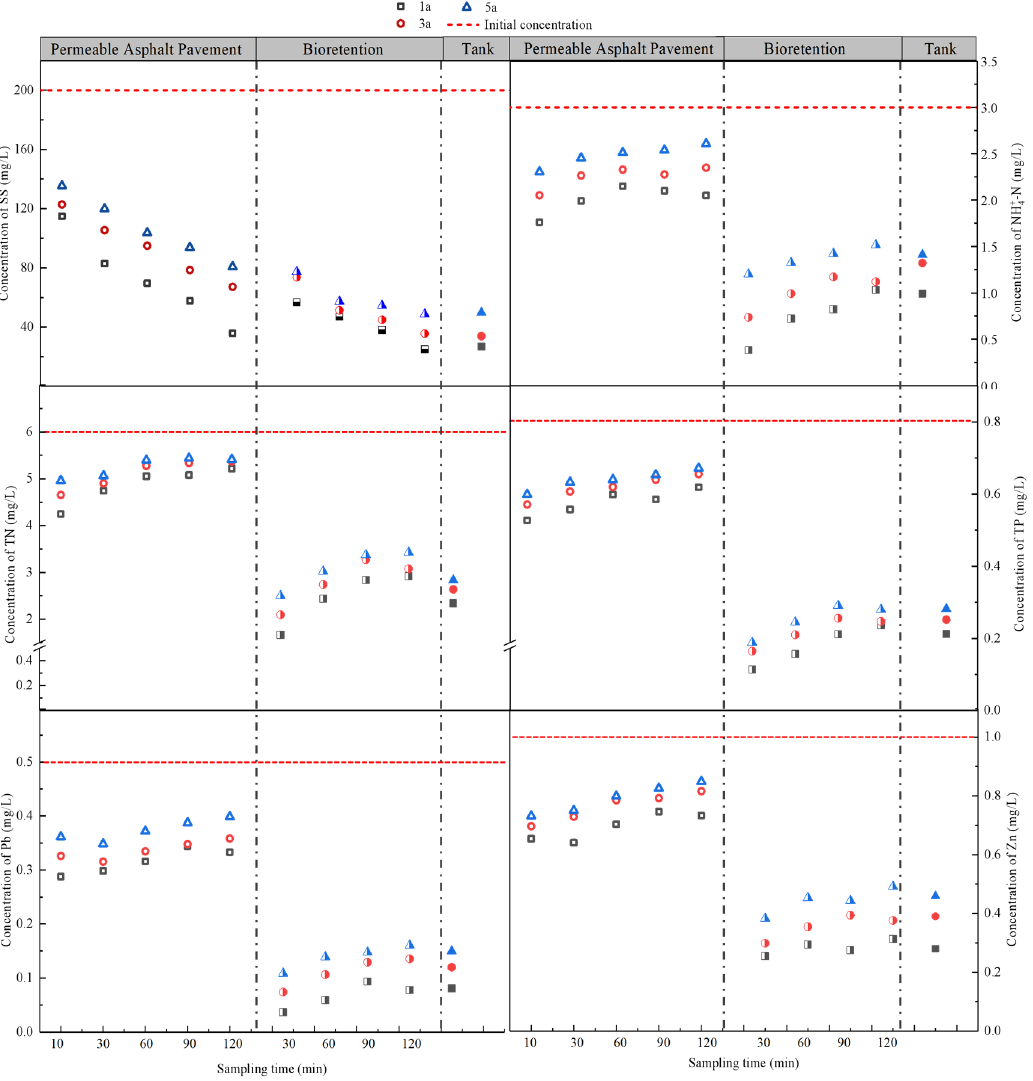
Figure 3. Pollutant removal characteristics of PB system under different rainfall intensities (n =